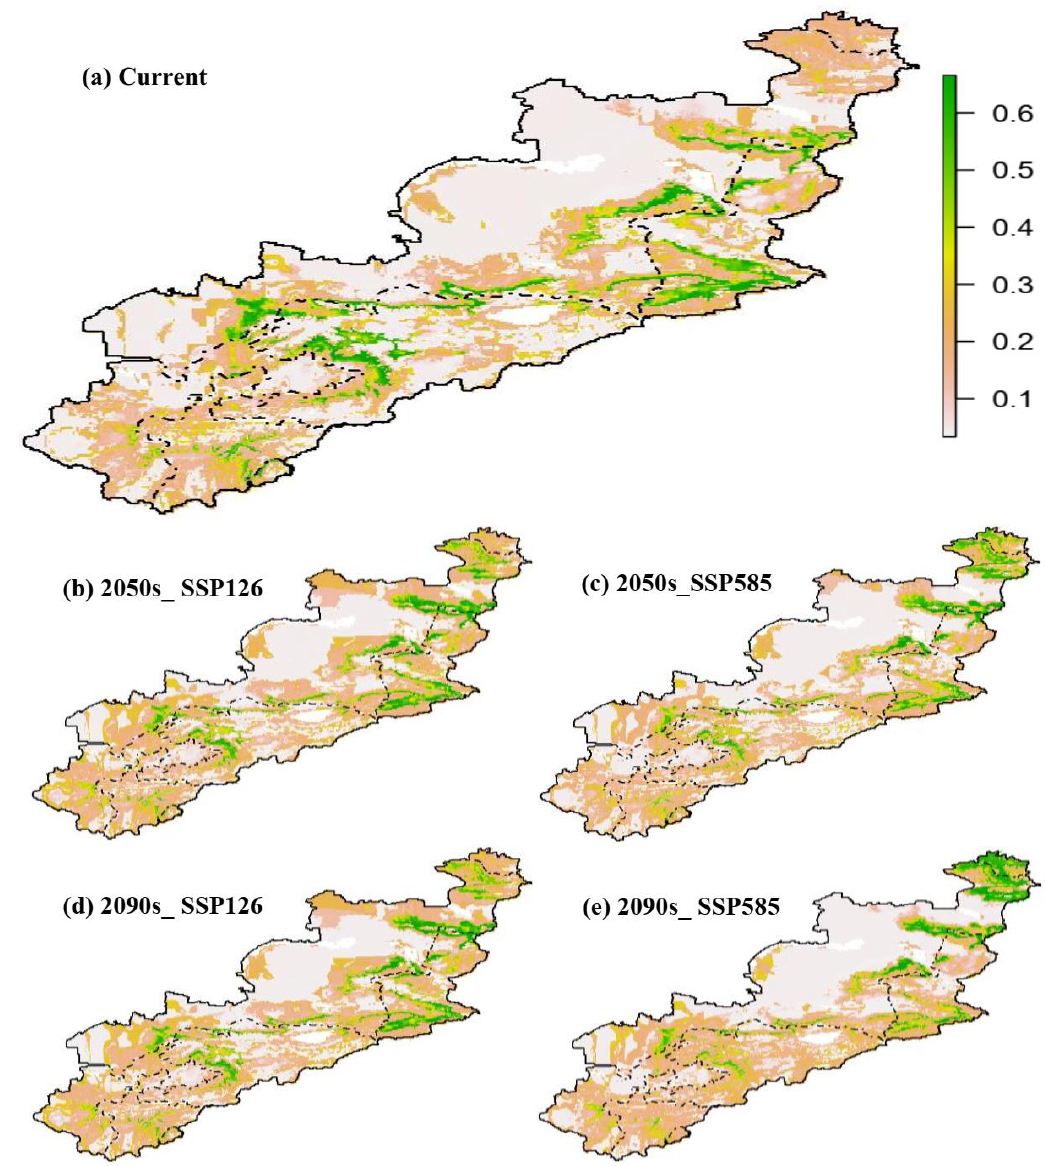
Figure 2. The distribution range of suitable habitat for wild apple in the current ( a ) and future scenarios ( b – e ). Green areas indicate highly suitable habitats, while gray regions indicate absence. The dashed lines show country boundaries in this region.